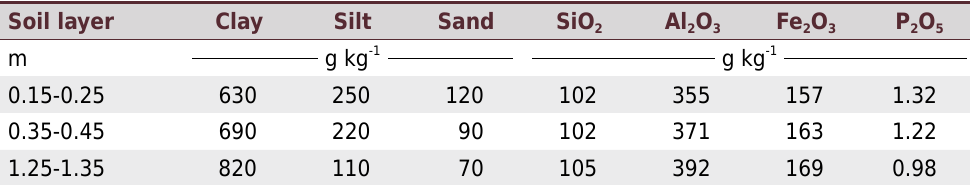
Table 2. Texture and contents of different oxides for the studied soil